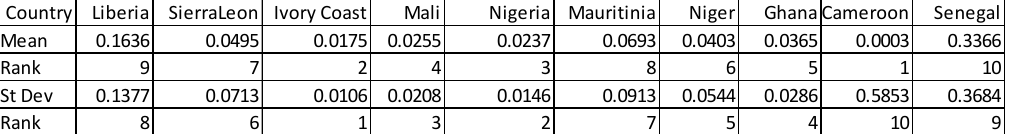
Figure A1. Foreign Direct Investment (FDI) as a ratio of Gross Domestic Product (GDP)% (1990–2017).